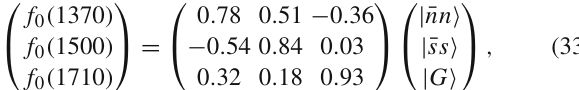
Table 4 The direct CP asymmetries ( A dir Decay